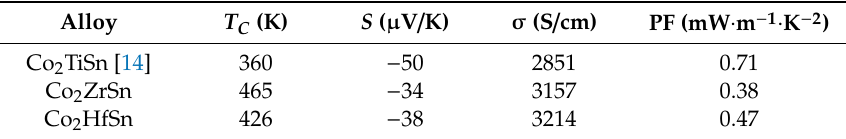
Table 3. Transport properties and Curie temperature of the Co 2 XSn (X = Ti, Zr, Sn) series of full-Heusler alloys. All properties are reported at 673 K. T C is the Curie temperature, S the Seebeck coe ffi cient, σ the electrical conductivity, and PF is the power